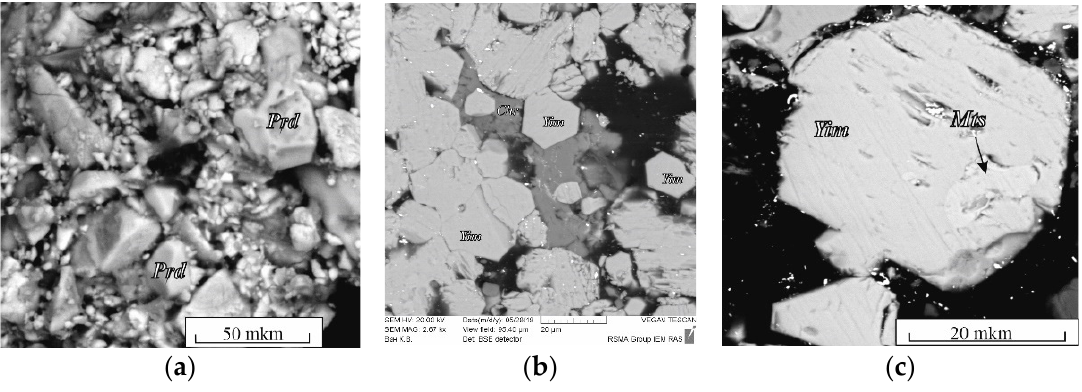
Figure 3. BSE images of run products in the systems: ( a ) chromite–rutile with H 2 O–CO 2 –K 2 CO 3 fluid; ( b ) synthetic crystals of yimengite, run B1-2; ( c ) chromite–ilmenite with H 2 O–CO 2 –K 2 CO 3 fluid (Table S2). Prd, priderite; Yim, yimengite; Mts, mathiasite.